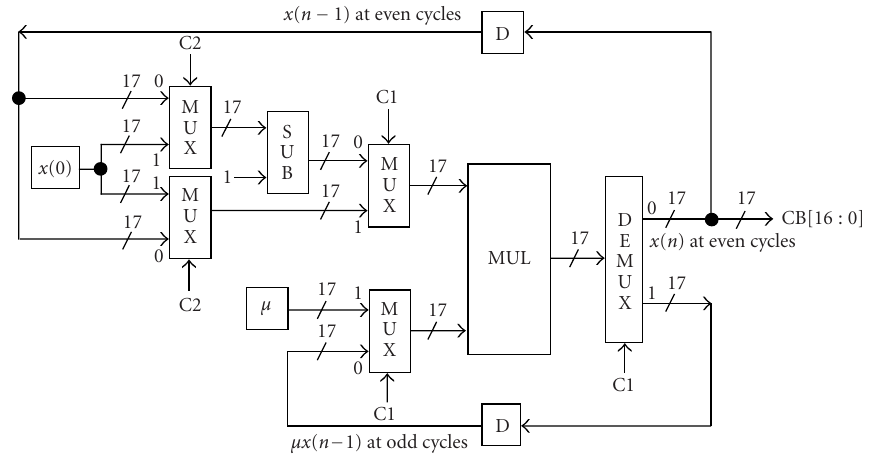
Figure 7: The architecture of the CBSG used in the proposed signal security system.